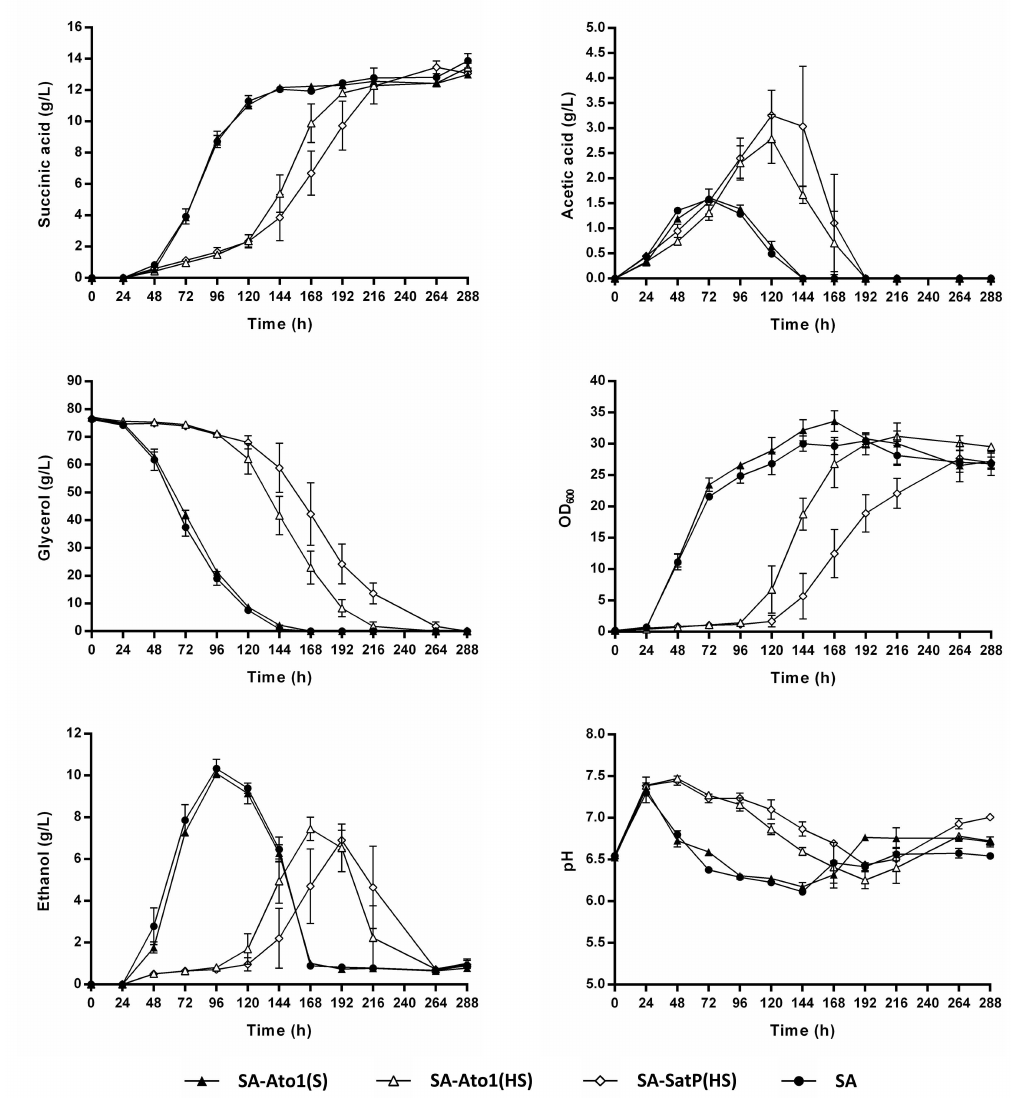
Figure 4. Saccharomyces cerevisiae strains SA-Ato1 (S) ( (cid:78) ), SA-Ato1 (HS) ( (cid:52) ), SA-SatP (HS) (